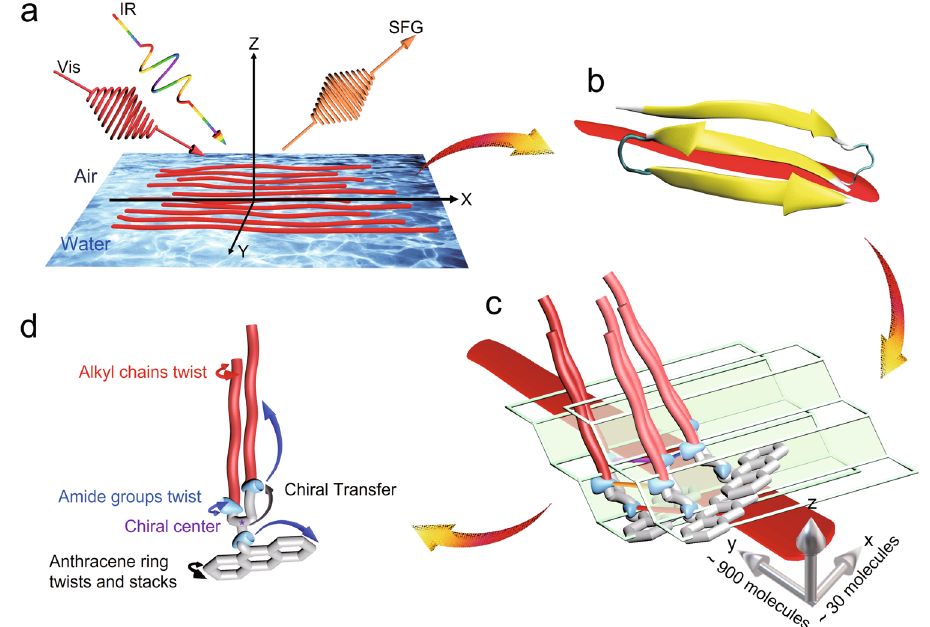
Fig. 4 | Schematic diagram of the supramolecular assembly arrangement and chiralitytransfermechanism. a A schematic representation of SFG to detect the nanorod structures formed by the self-assembly of L - /D -GAn molecules at the interface. b L - /D -GAn molecules assemble at the interface to form antiparallel β - sheet-like structures and further assemble into nanorod structures. c Schematic diagram of the intermolecular interactions and hierarchical assembly process of L - /D -GAn molecules. The nanorod contains about 30 molecules along the about 900 molecules along the y -axis, and one molecule along the z -axis (alkyl